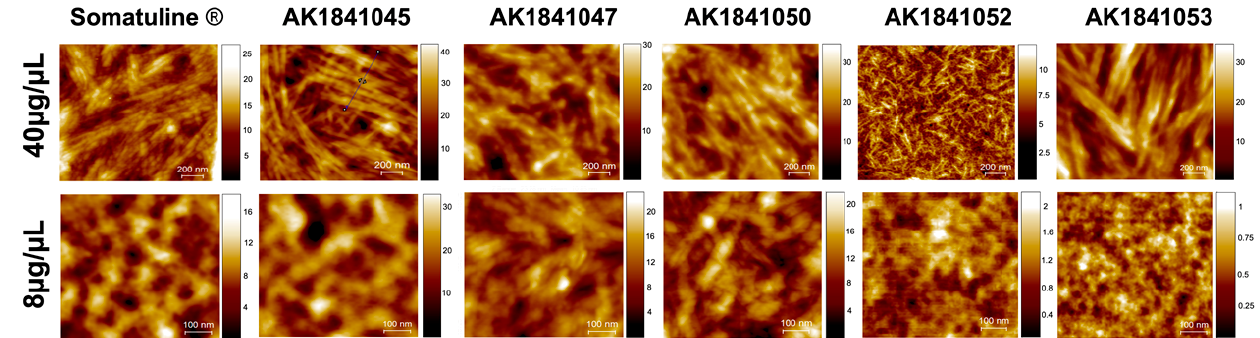
Figure 6. Topographic AFM images (0.6 × 0.6 μ m 2 ) acquired on mica at room temperature in dry conditions. For each sample, we acquired two concentrations (40 μ g/ μ L and 8 μ g/ μ L). AFM measurements were performed in tapping mode configuration using silicon nitride cantilevers with an elastic constant of 0.6 N/m (MSNL Bruker) and a nominal tip radius of 10 nm. The height line AFM profiles were also shown for Somatuline, AK1841045, and AK1841052 (Figures 7–9). The topographic AFM image and height line profile of Somatu-